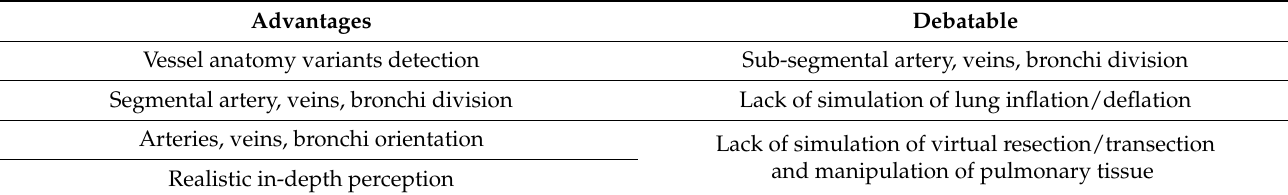
Table 3. VR HDM usefulness in preoperative